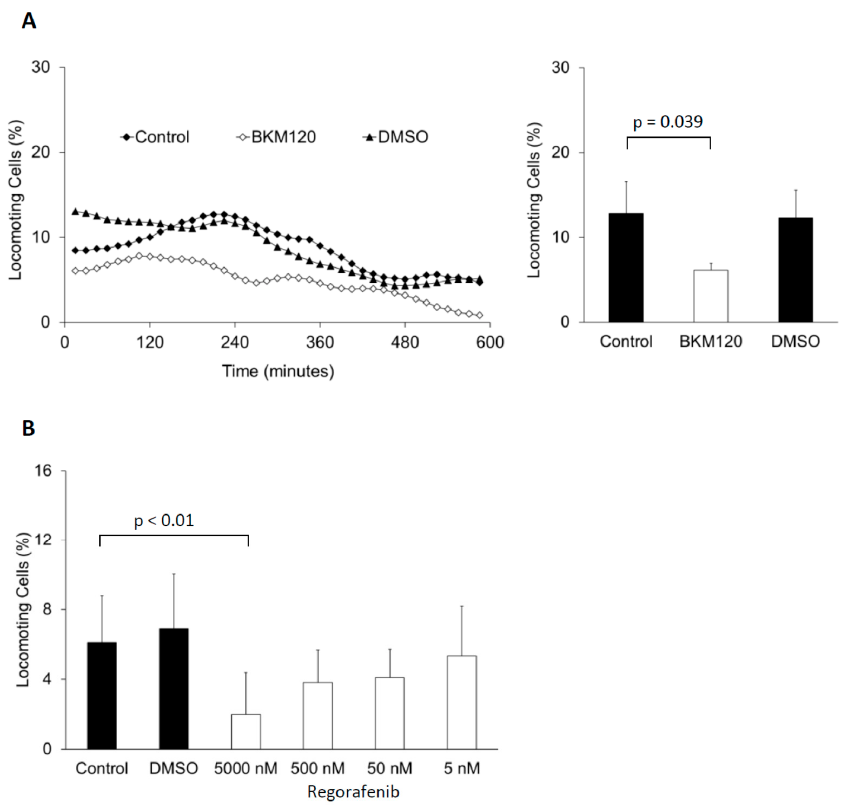
Figure 1. Cell migration was performed using the human estrogen receptor–positive, luminal-like breast carcinoma cells MCF-7 with regard to BKM120 ( n = 3; A ); and the human epitheloid pancreatic cancer cell line PANC-1 with regard to Regorafenib ( n = 7; B ). Due to limited availability of material, only three experiments have been performed with one concentration for BKM 120. Both cell lines were obtained from the Cell Lines Service GmbH (Eppelheim, Germany). DMSO concentrations correspond to the highest concentration used to dissolve the substances. In ( A ), the left graph shows the time course of the migratory activity, the right graph displays the mean activities and standard deviations after four hours; In ( B ), the columns show the mean activities and standard deviations of the entire observation time of 10